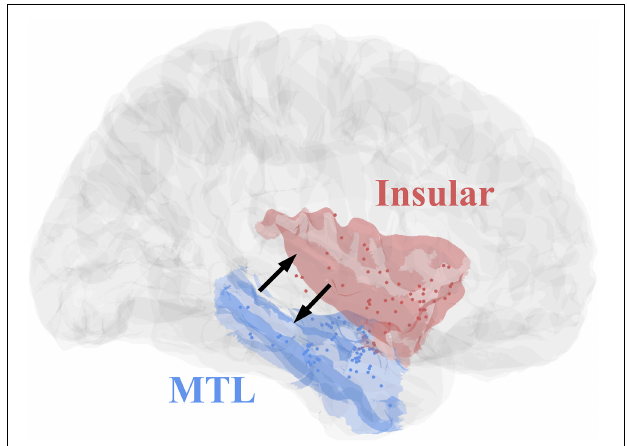
FIGURE 5 | Contact distributions and direct connectivity between MTL and insular, revealed by CCEP. The contacts’ distributions of patients ( Table 1 ) in MNI152 standard space (Insular, red; MTL, blue). The two black arrows indicate significant bidirectional connectivity between the insular and medial temporal lobe based on the result of this